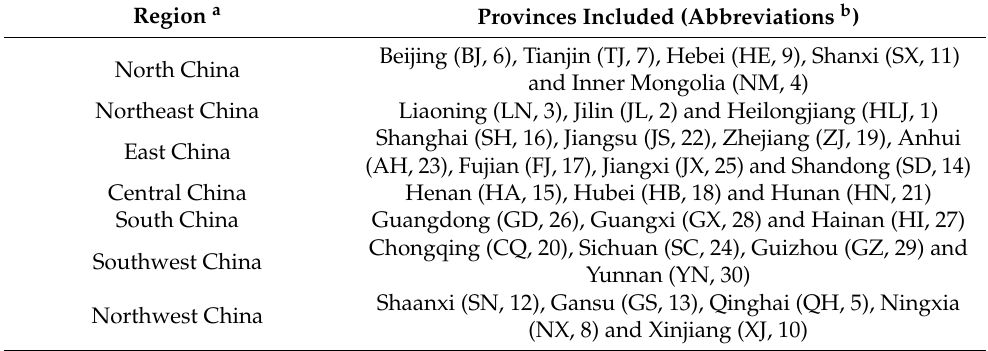
Table A1. Province division and